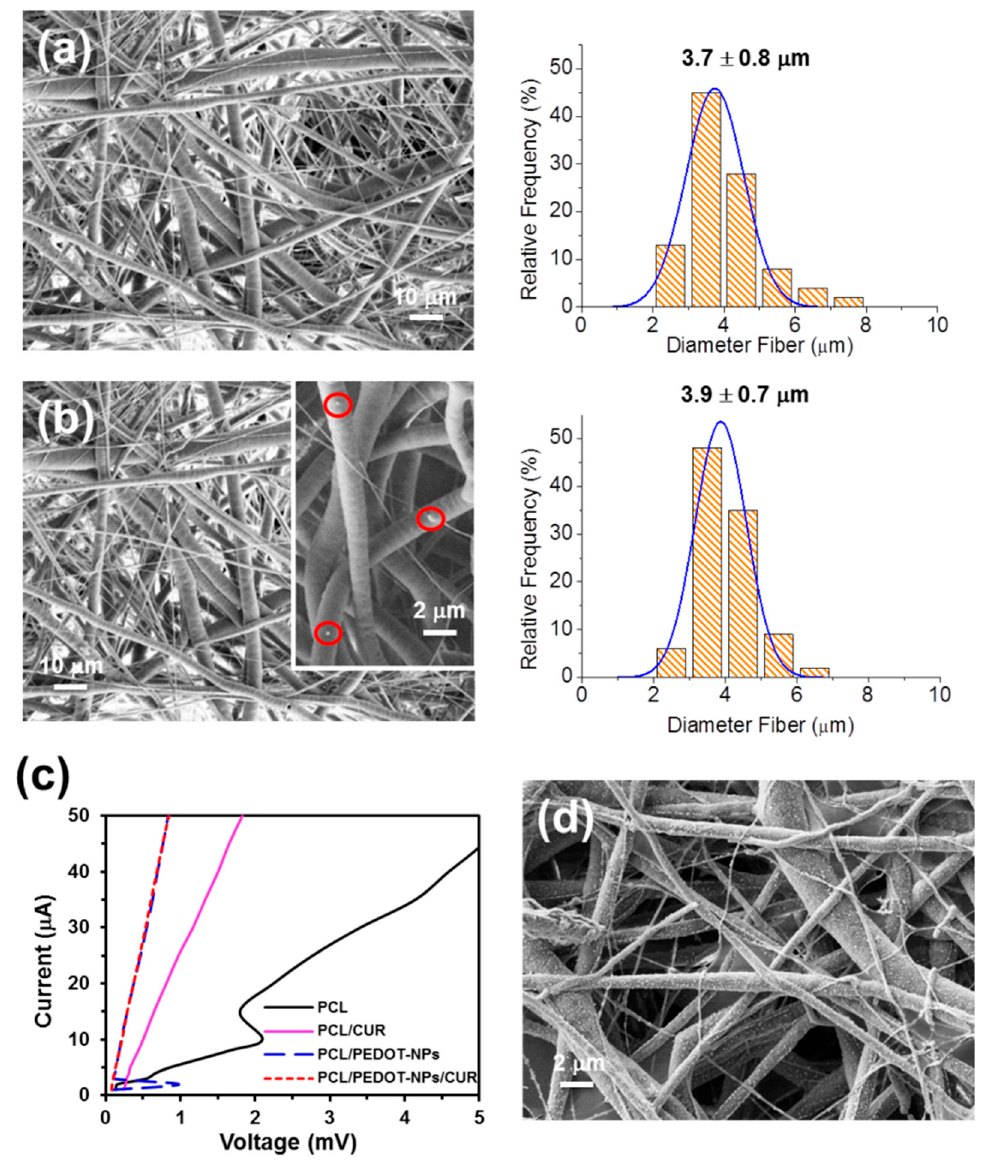
Figure 4. SEM micrographs of electrospun ( a ) poly ( ε -caprolactone) (PCL) and (b) PCL/PEDOT-NPs/CUR fibrous mats before electrical stimulation. Effective-diameter histograms derived from SEM measurements and average values are also displayed. The inset in ( b ) shows a few PEDOT-NPs (red circles) on the surface of the fibres. ( c ) Typical I–V curves obtained using different applied voltages. ( d ) Representative SEM micrograph of a PCL/PEDOT-NPs/CUR fibrous mat after applying a voltage of 0.5 V for 1 min.